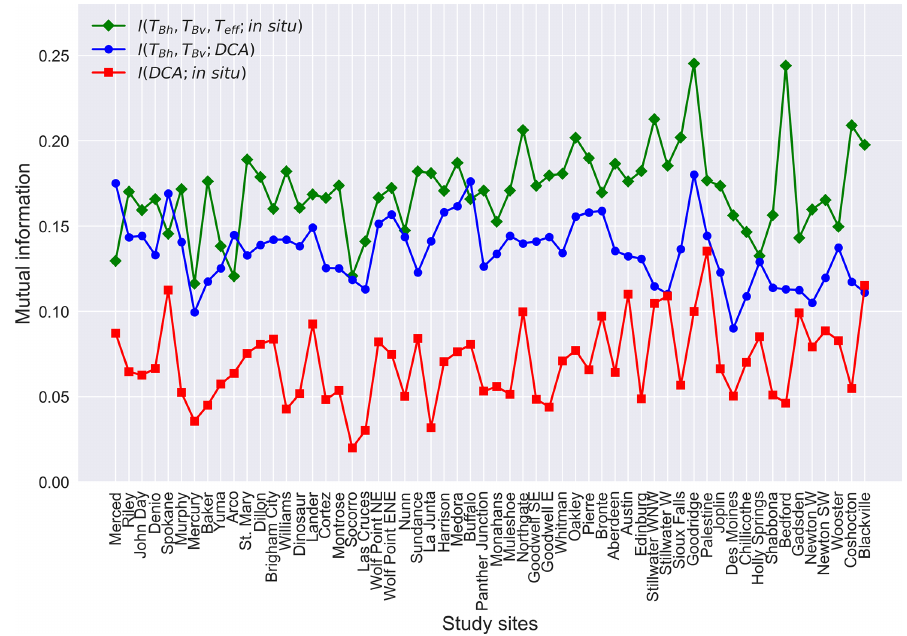
Figure 3. Mutual information between horizontally polarized brightness temperature ( T Bh ), vertically polarized brightness temperature ( T Bv ), soil effective temperature ( T eff ), and in situ soil moisture; mutual information between horizontally polarized brightness temperature ( T Bh ), vertically polarized brightness temperature ( T Bv ), and DCA soil moisture; mutual information between DCA soil moisture and in situ soil moisture. See Fig. 2 caption for site